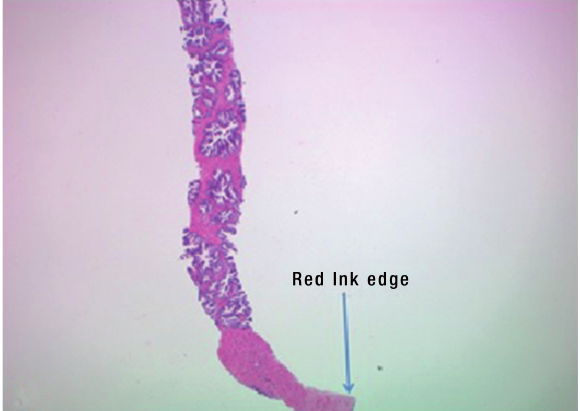
Figure 5 - Distance from peripheral margin to malignant